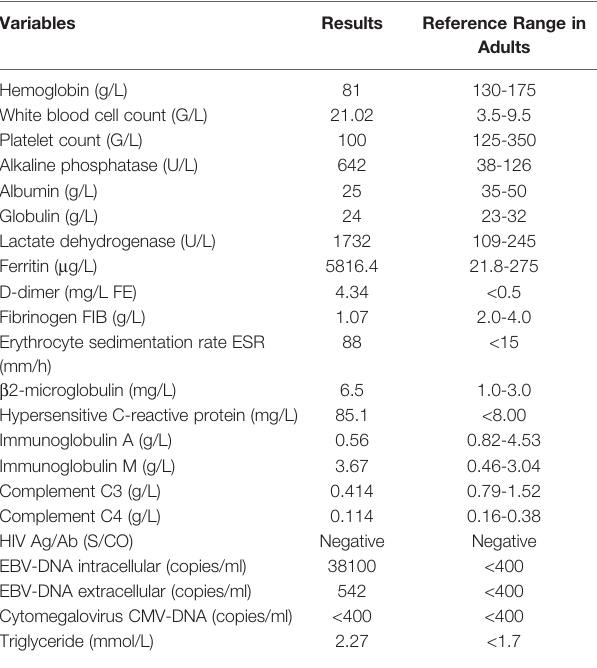
TABLE 1 | Laboratory Examinations.